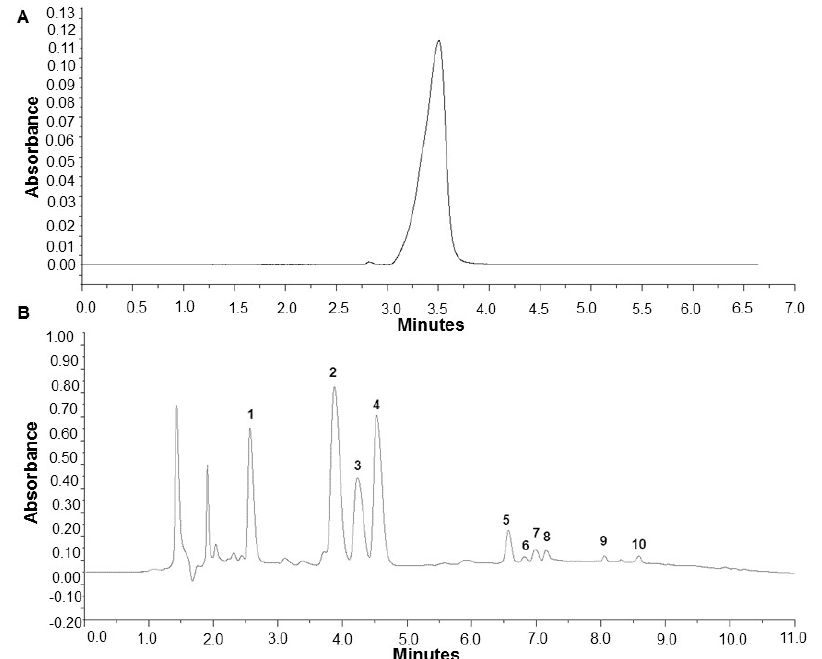
Figure 1. High-Performance Liquid Chromatography with Diode-Array Detection (HPLC-DAD) chromatograms for Arabica co ff ee infusion. ( A )—ca ff eine, ( B )—polyphenols: 1—neochlorogenic acid, 2—cryptochlorogenic acid, 3—chlorogenic acid, 4—ca ff eine, 5—ferulic acid, 6–10—dica ff eoylquinic or feruloylquinic acids isomers.